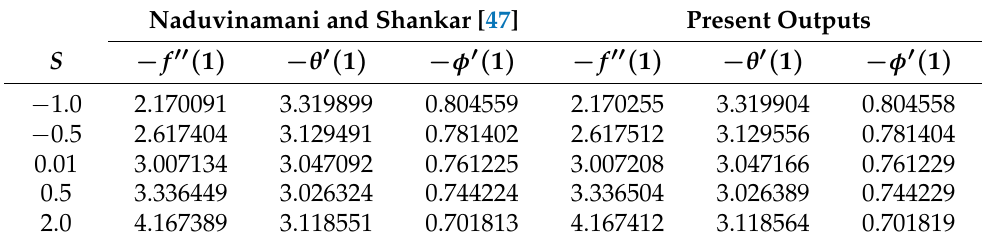
Table 2. Numerical outputs of − f (cid:48)(cid:48) ( 1 ) , − θ (cid:48) ( 1 ) and − φ (cid:48) ( 1 ) for S as λ 1 → ∞ , Da → ∞ , De = N b = 10 − 10 , Ha = γ = N t = 0, δ = 0.1 and Pr = Ec = Le = R = 1.